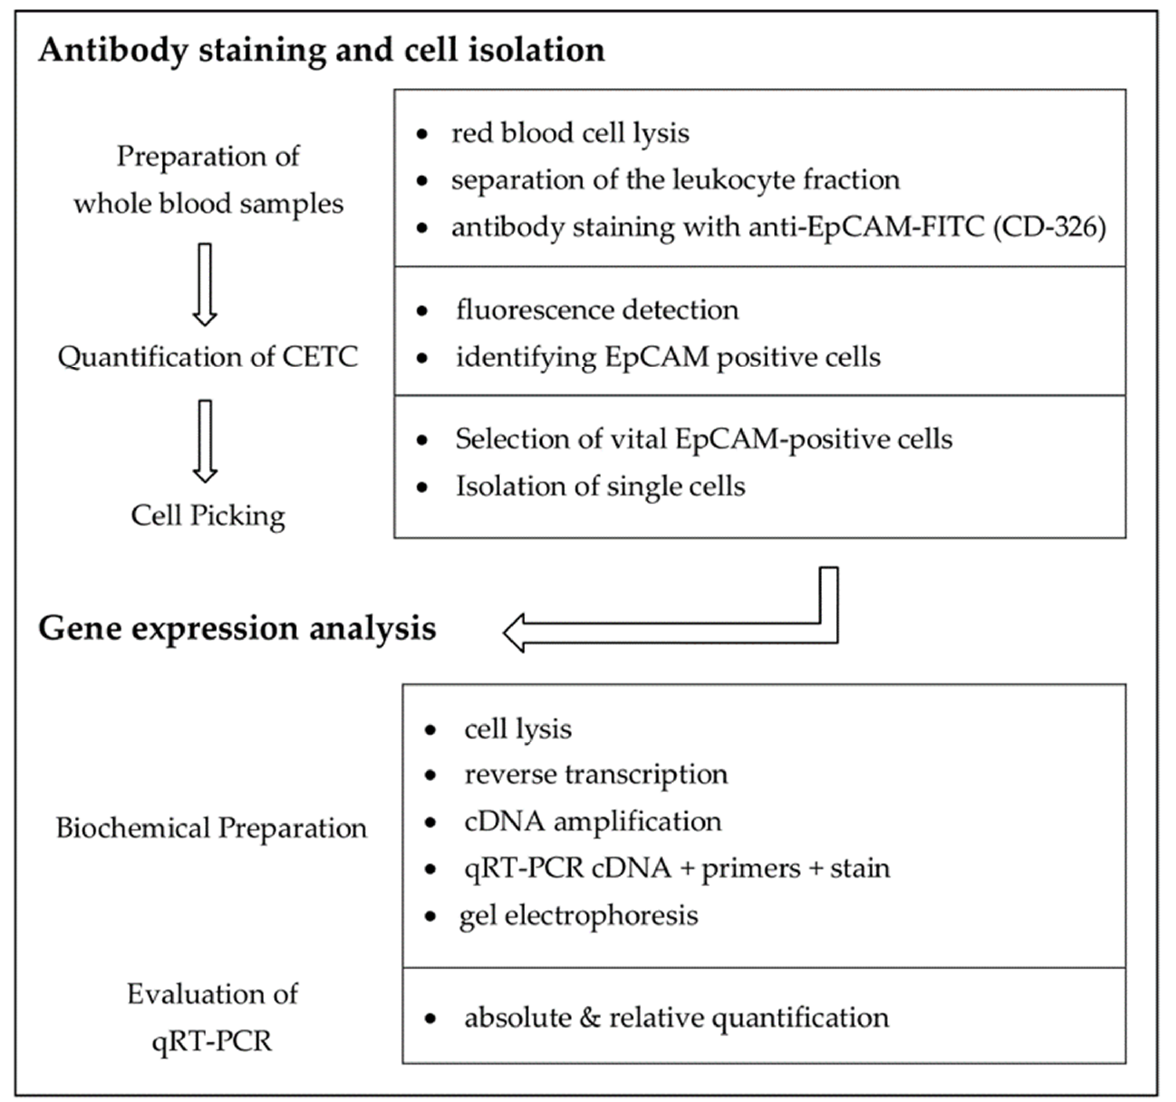
Figure 1. Workflow of antibody staining, cell isolation, and determination of mRNA contents.